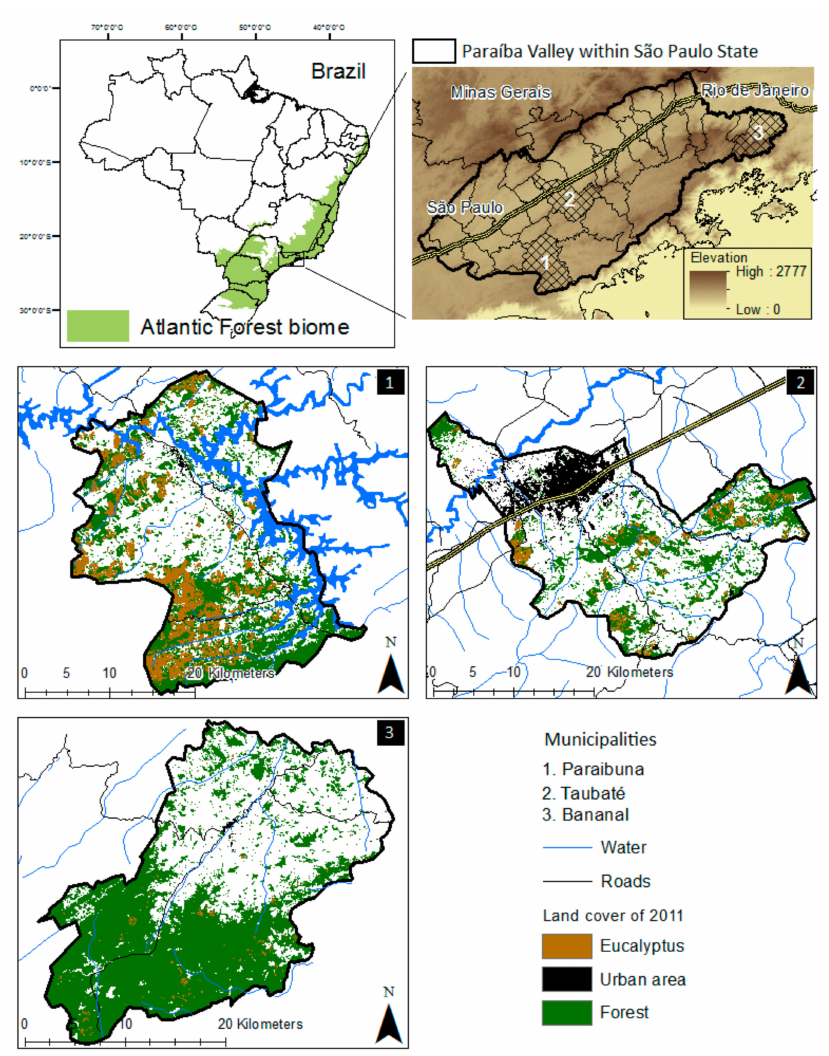
Figure 1. Selected municipalities studied in the Para í ba Valley, S ã o Paulo state,